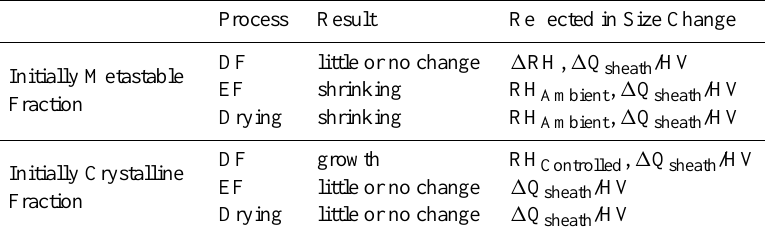
Table A1. AS-TDMA RH probe calibration